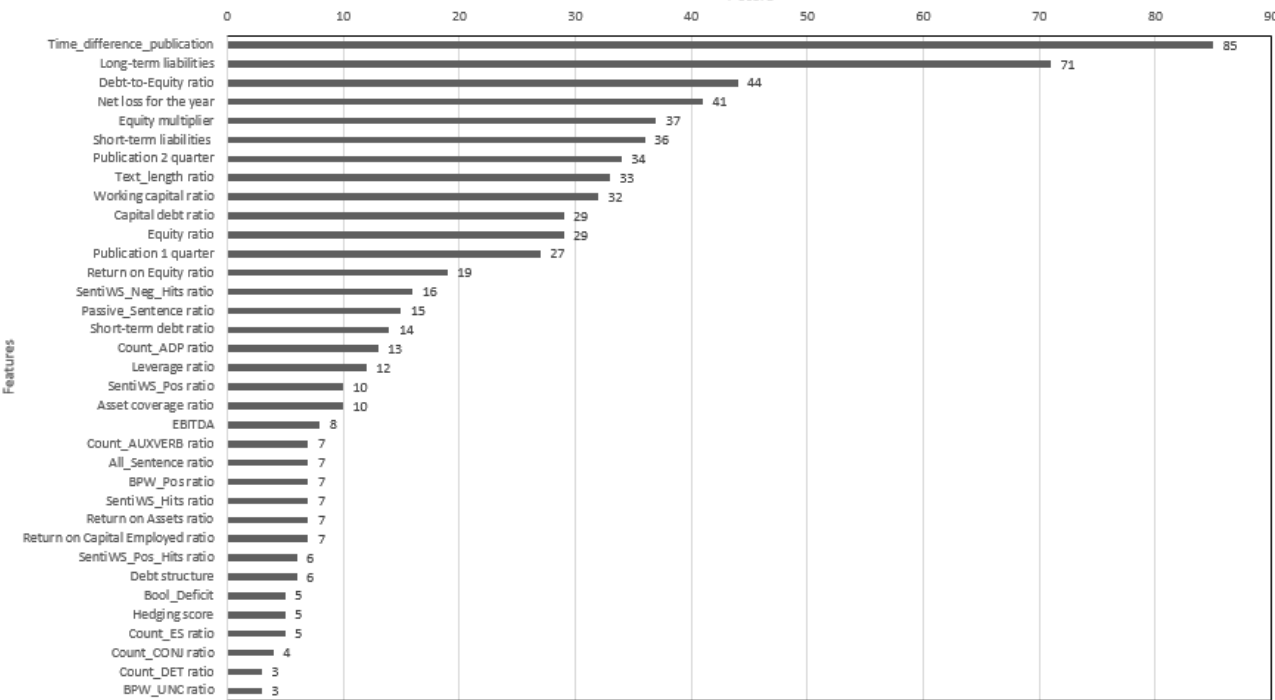
Figure 2. Feature Importance (Top 35) based on supplemented textual feature set (F A + F T ).